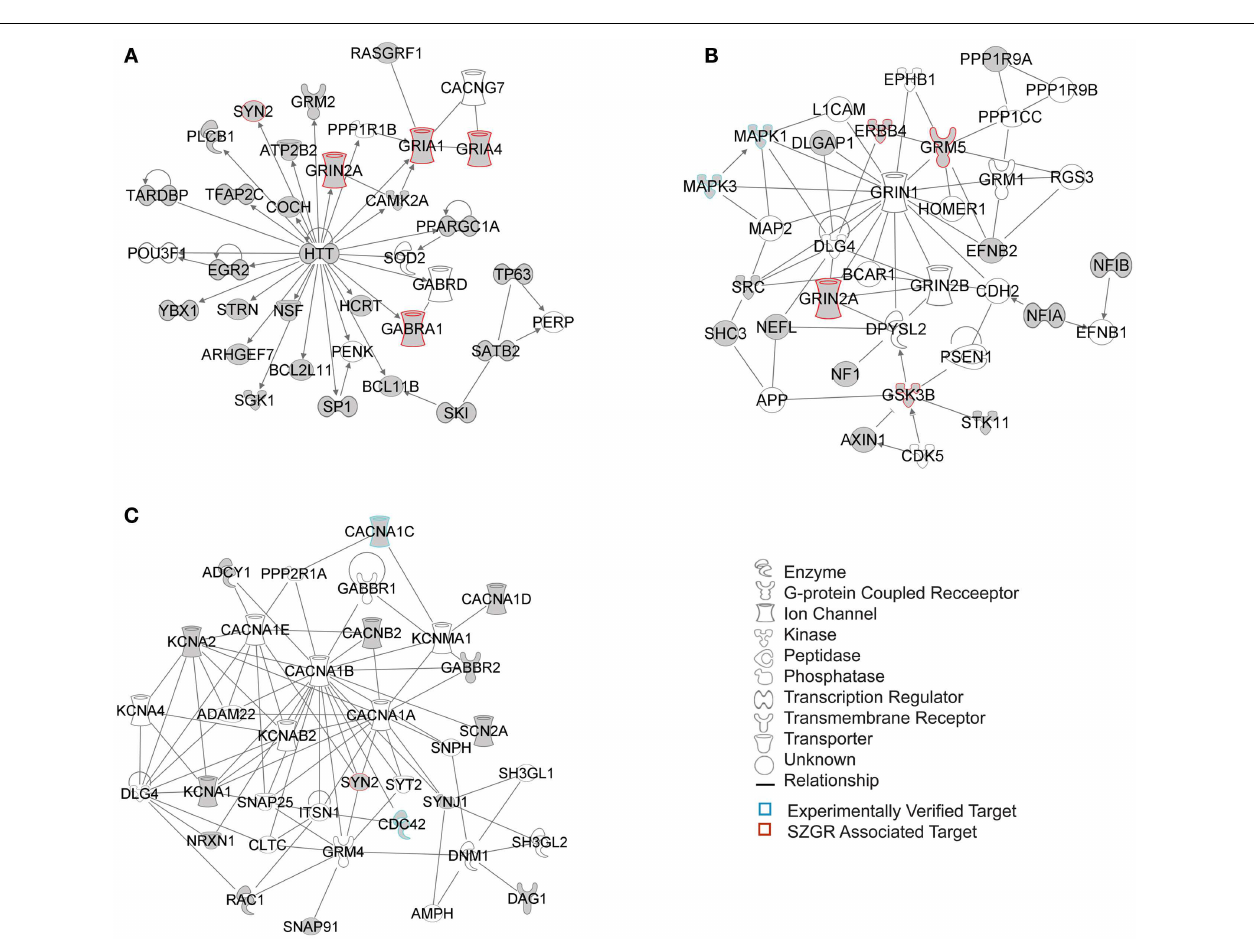
FIGURE 7 |Top 3 scoring IPA network analysis generated networks for 202 nervous system development and function subset of putative and verified targets .The three top scoring networks identified were: (A) “behavior, hereditary disorder, neurological disease,” with a score of 29, (B) “cell morphology, cellular assembly and organization, cellular development,” with a score of 12, and (C) “cell-to-cell signaling and interaction, nervous system development and function, neurological disease,” with a score of 10.